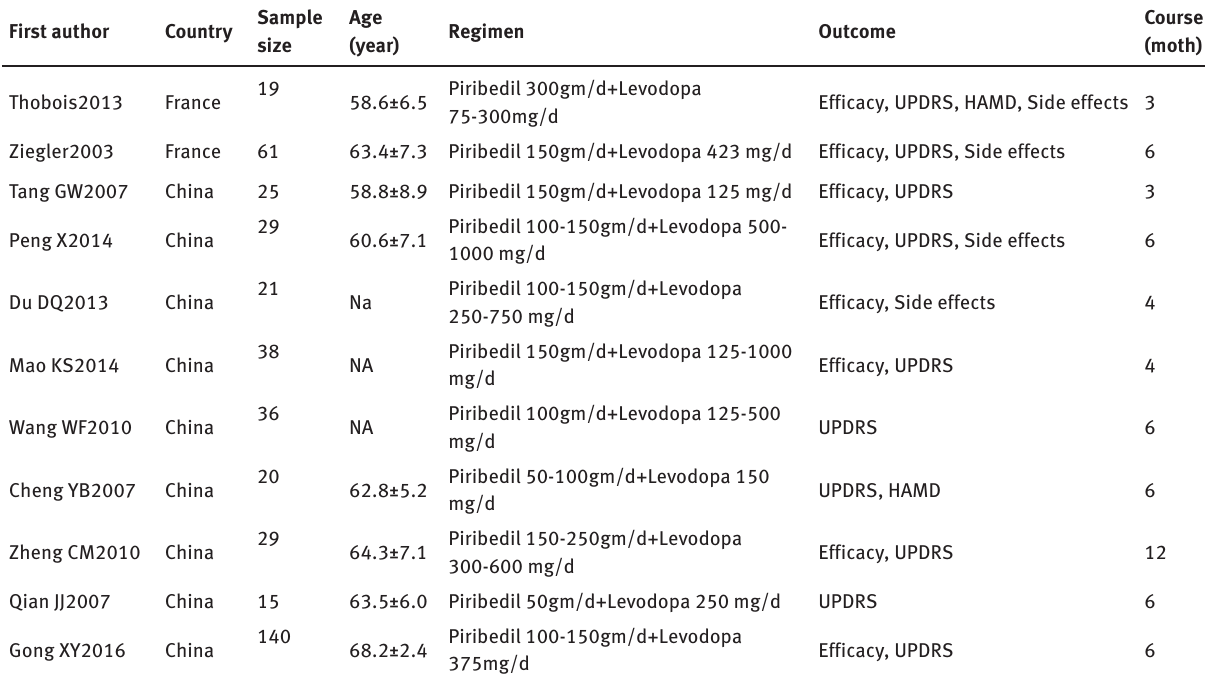
Table 1: The general features of the included RCTs